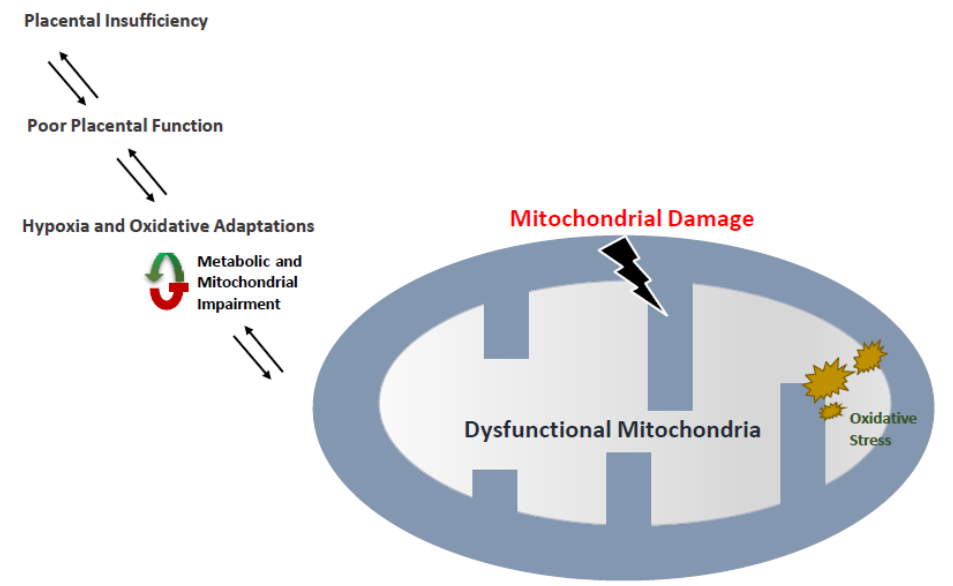
Figure 3. Mitochondria and IUGR. Insufficient placental growth results in IUGR, which causes metabolic and mitochondrial rearrangements by creating a hypoxic environment during fetal development. In these circumstances, the metabolic and mitochondrial imbalance can eventually result in the development of IUGR under oxidative stress conditions.